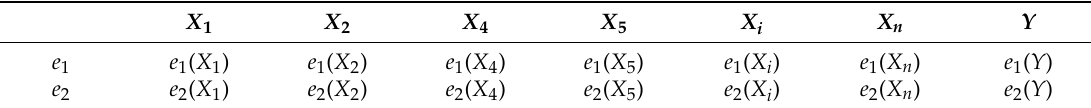
Table 1. Values of feature X i for the example e 1 and e 2